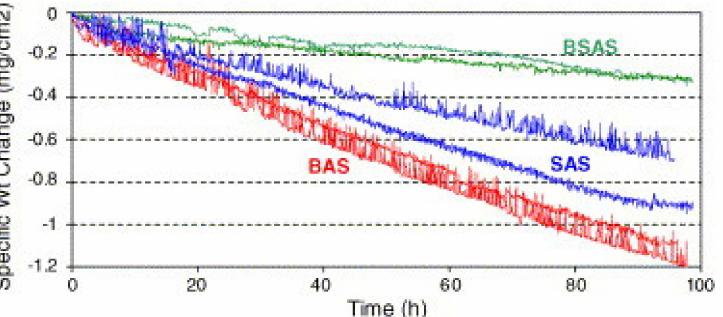
Figure 10. Volatility of hot-pressed BSAS (barium-strontium-aluminum-silicate) family materials exposed to 50 vol.% H 2 O-balance O 2 flowing at 4.4 cm/s at 1500 ◦ C and 1 atm total pressure [45].